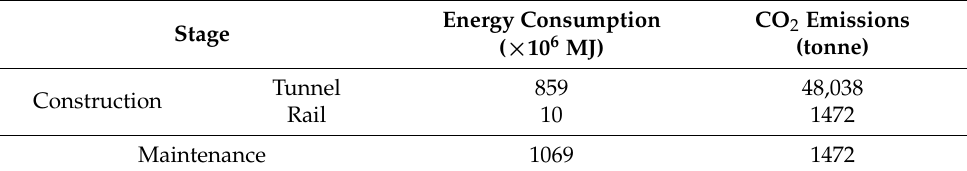
Table 4. Life-cycle energy consumption and CO 2 emissions of a railway tunnel construction